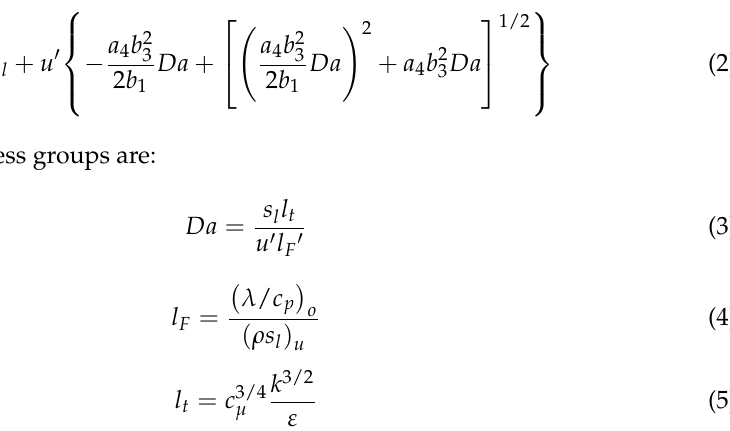
Y e s Y e s Figure 3. Flow chart of the PSO algorithm. Figure 4. Optimization iterative diagram. To further explore the physics and find the optimal parameters used for this simulation, we searched for the parameter space in the G-equation, and the relevant optimization of the model parameters was performed using the improved particle swarm algorithm (PSO). Three parameters in the G-equation model were used as design variables, and the objective function mainly considered A and B. A is the integrated heat release, and B is the pressure. The objective function is shown in Equation (7), as follows: